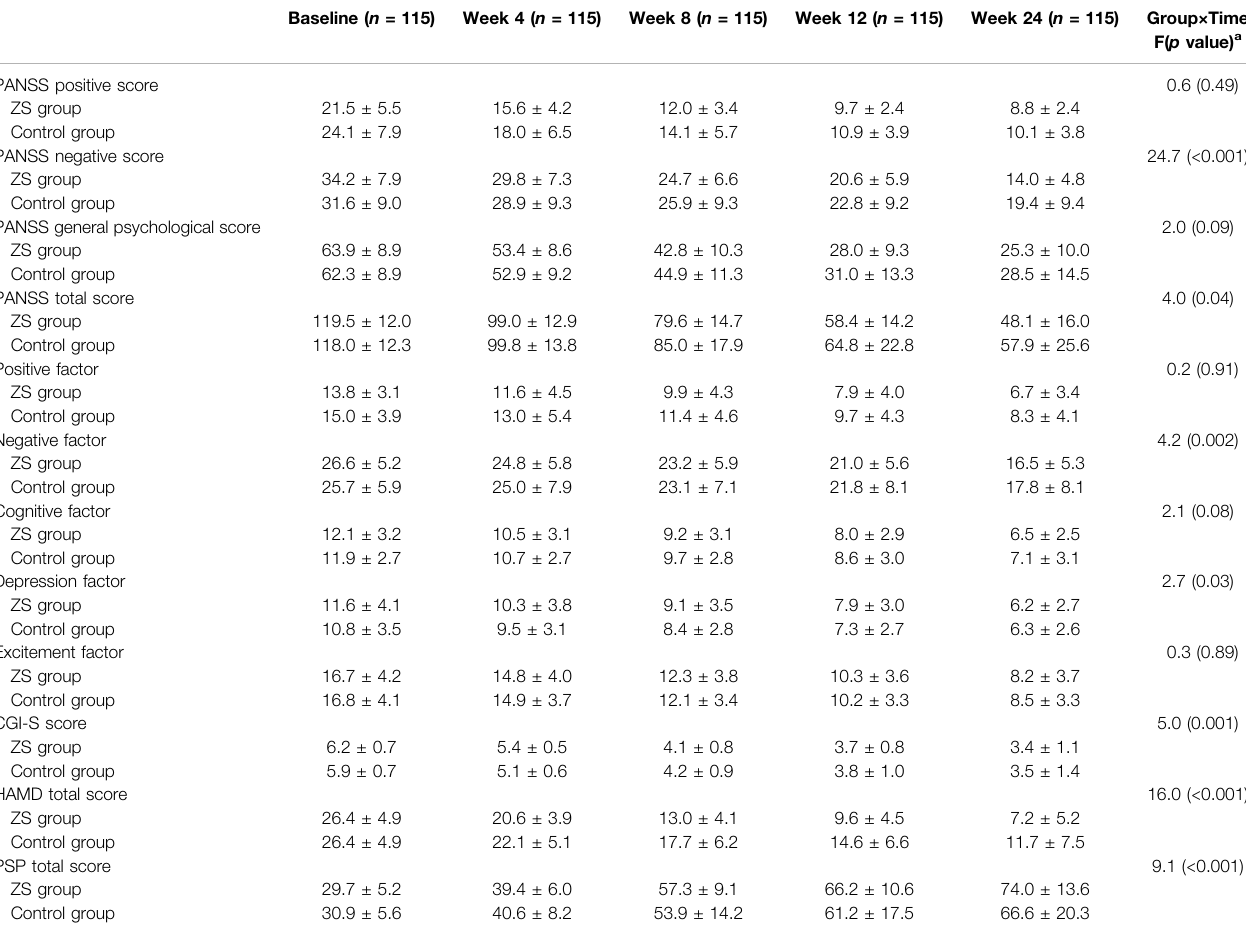
TABLE 2 | PANSS scores, HAMD score, CGI-S and PSP at baseline, week 4, week 8, week 12 and week 24 in ziprasidone in combination with sertraline (ZS) group and ziprasidone monotherapy (control) group (mean ± standard